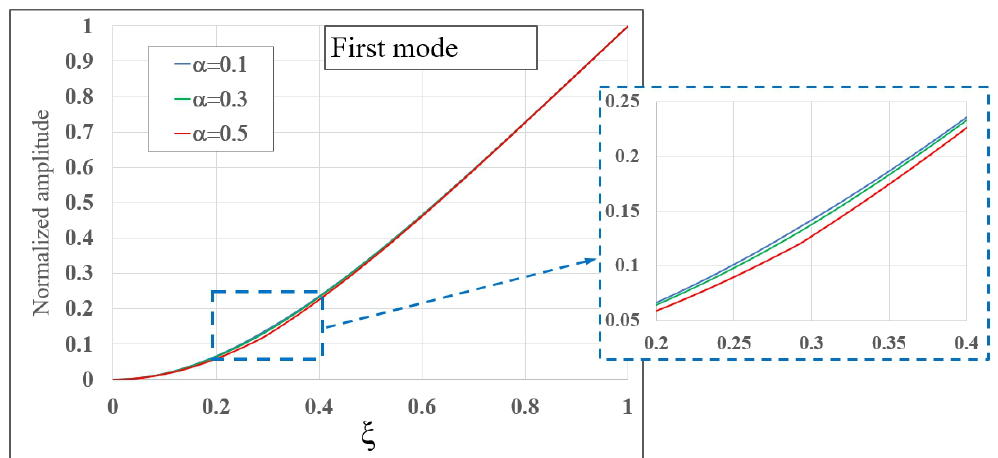
Figure 7. First mode shape for the case r = 0.2, S L = 120, ξ c = 3, Ω = 6 rad/s and for three different crack depths ( α = 0.1,0.3 and 0.5).